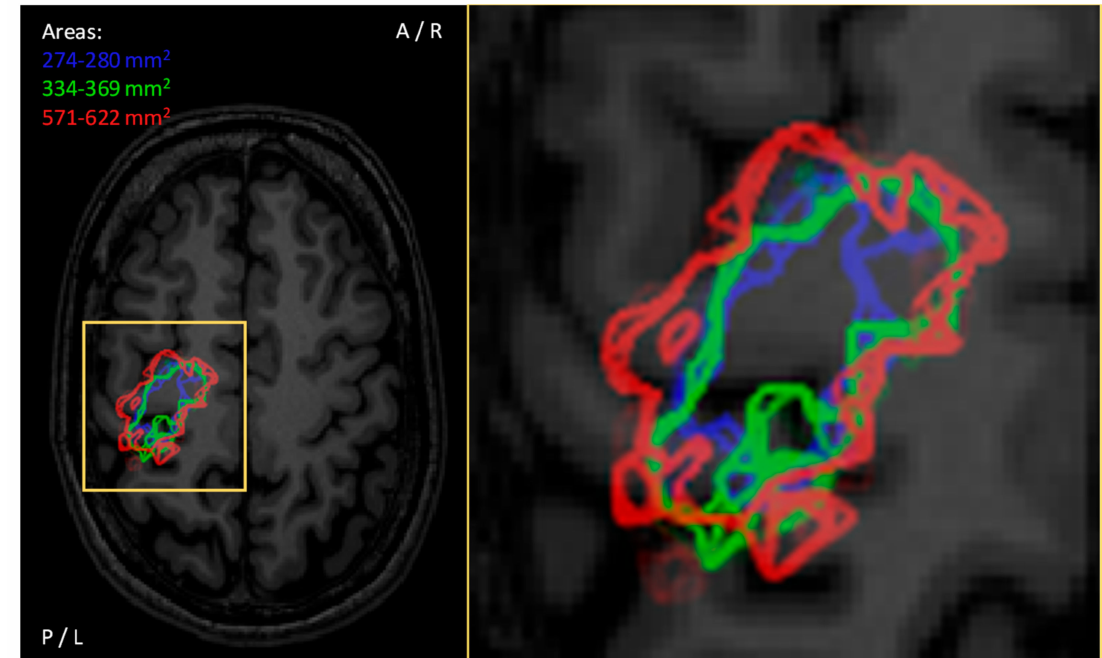
Figure 7. Visualization of the motor map resulting from mapping with three SIs ( blue : 110% of the rMT, green : Mills–Nithi UT method [108], red : 120% rMT). Data from each of the experiments were bootstrapped 1000 times, assuming that 10% of the responses observed were false negative. The image is visualized in neurological projection. The stimulations were placed on average 0.4 mm apart. The 95% confidence limits are indicated for quantified areas in the